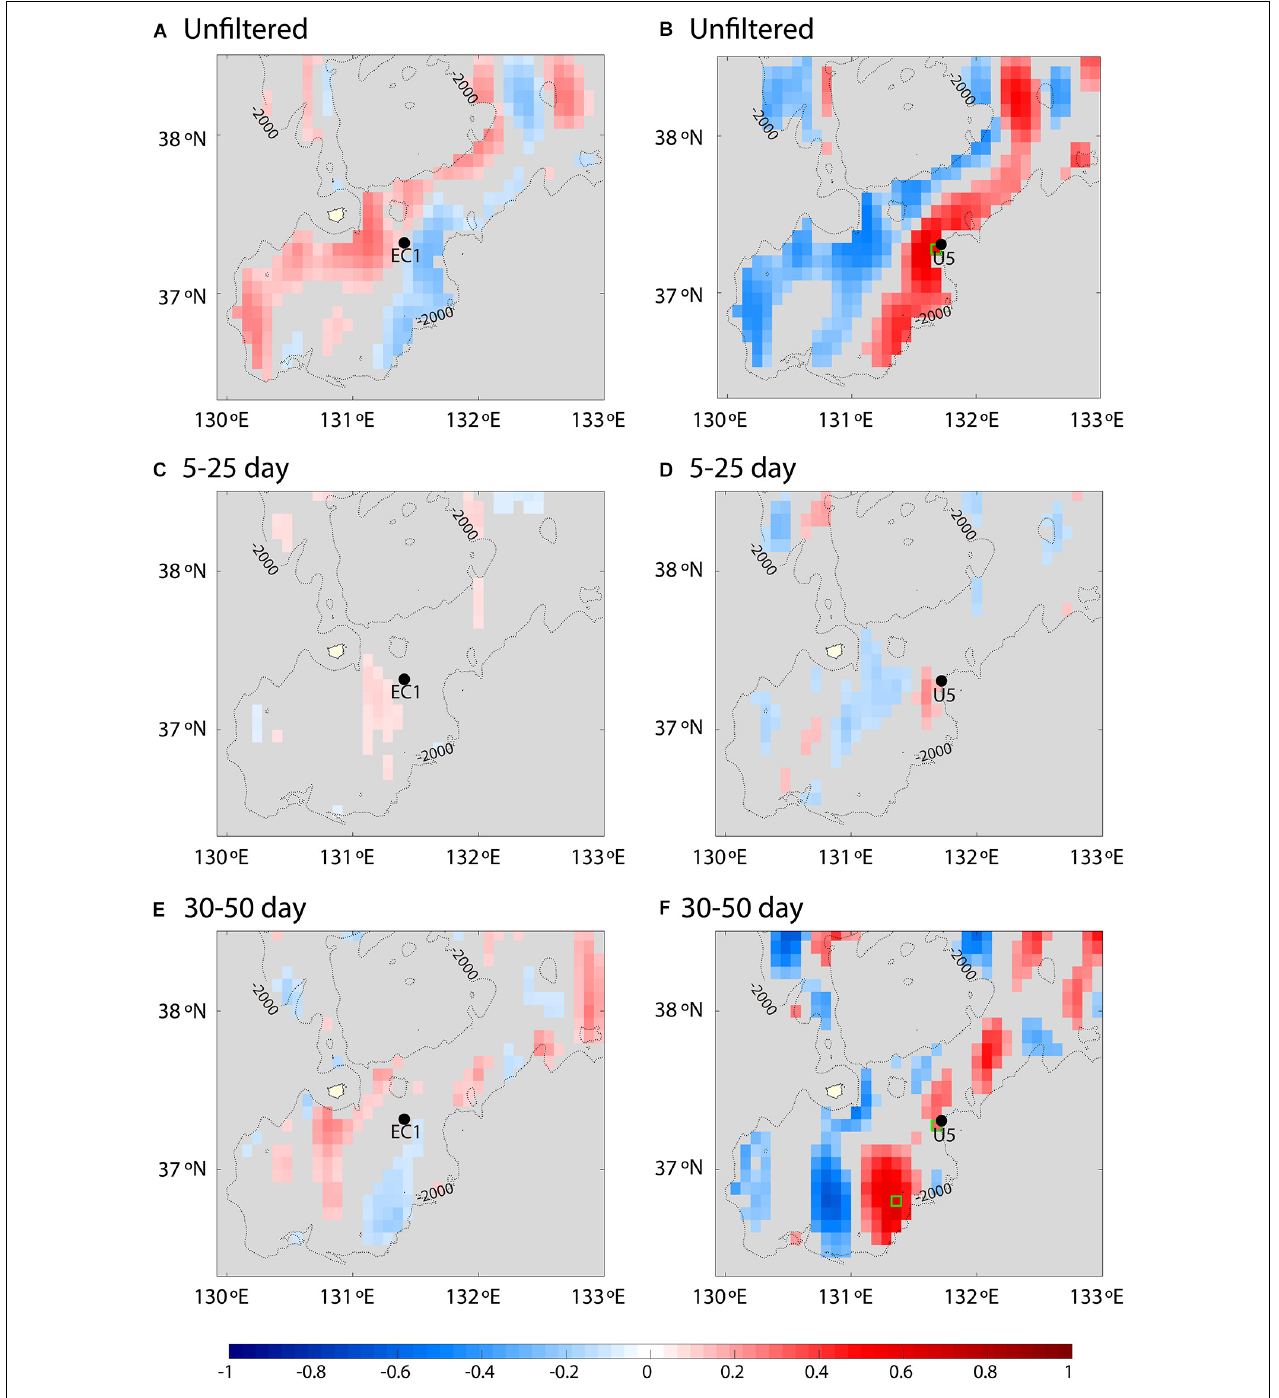
FIGURE 5 | Correlation (values below 95% confidence level are discarded) between modeled (HYCOM) and observed v currents for EC1 (left) and U5 (right) at 2000 m for (A,B) the whole period band, (C,D) shorter intraseasonal bands, and (E,F) longer intraseasonal bands. Grids selected for comparison of observed and modeled abyssal currents are marked by green